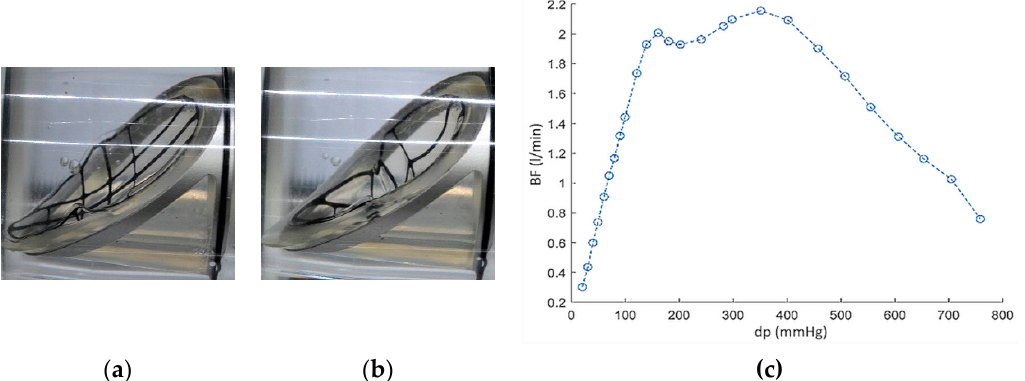
Figure 12. ZNP-Ti valve: leaflet deformation for ( a ) dp = 100 mmHg, ( b ) dp = 760 mmHg and ( c ) influence of leaflet deformation on valve sealing (visible for dp > 400 mmHg).